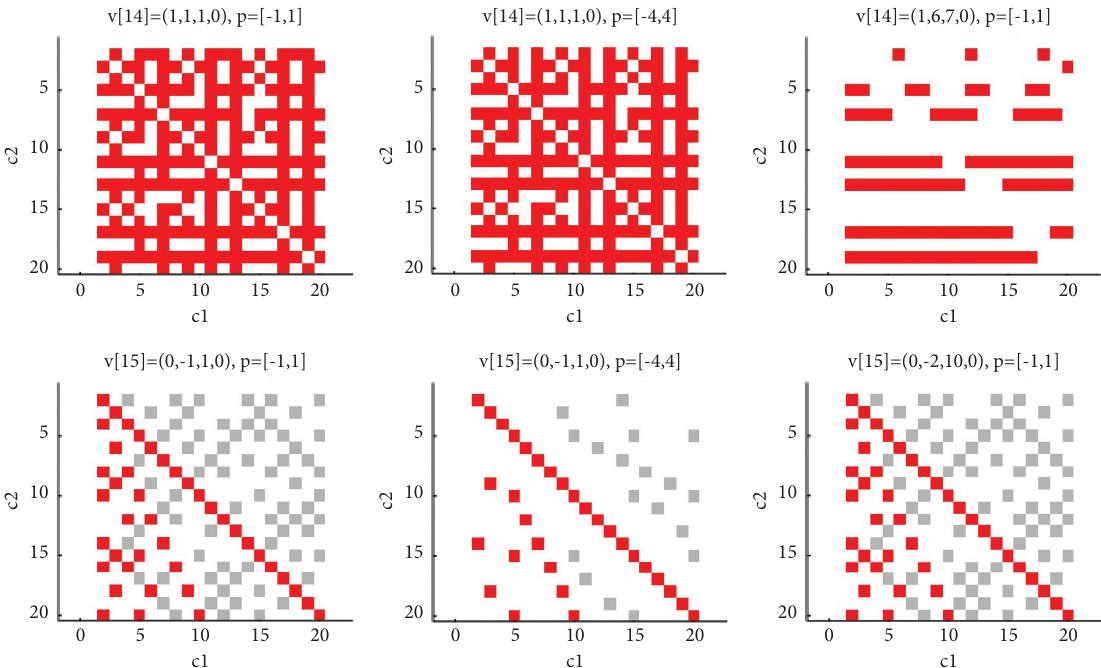
Figure 4: Attractors for tuples v global fxed points are those with c